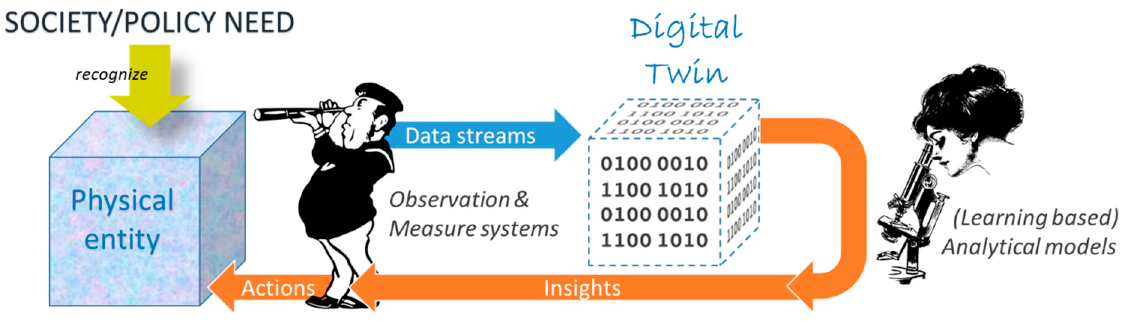
Figure 2. DT philosophy and archetype .